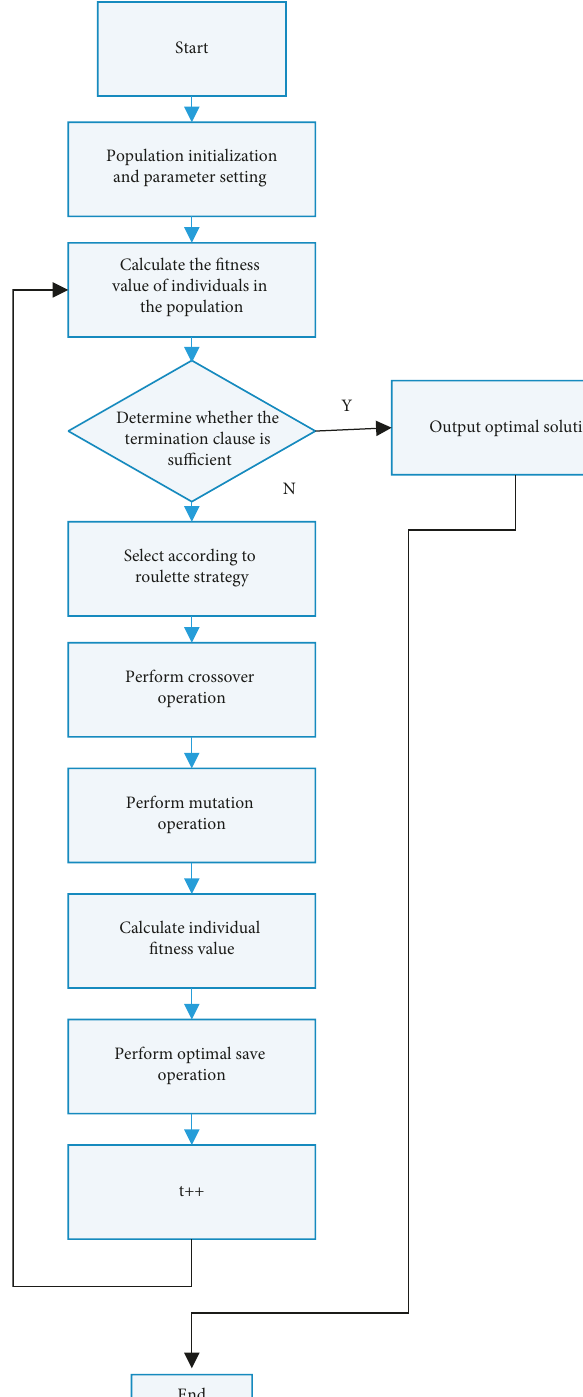
Figure 1: Improved genetic